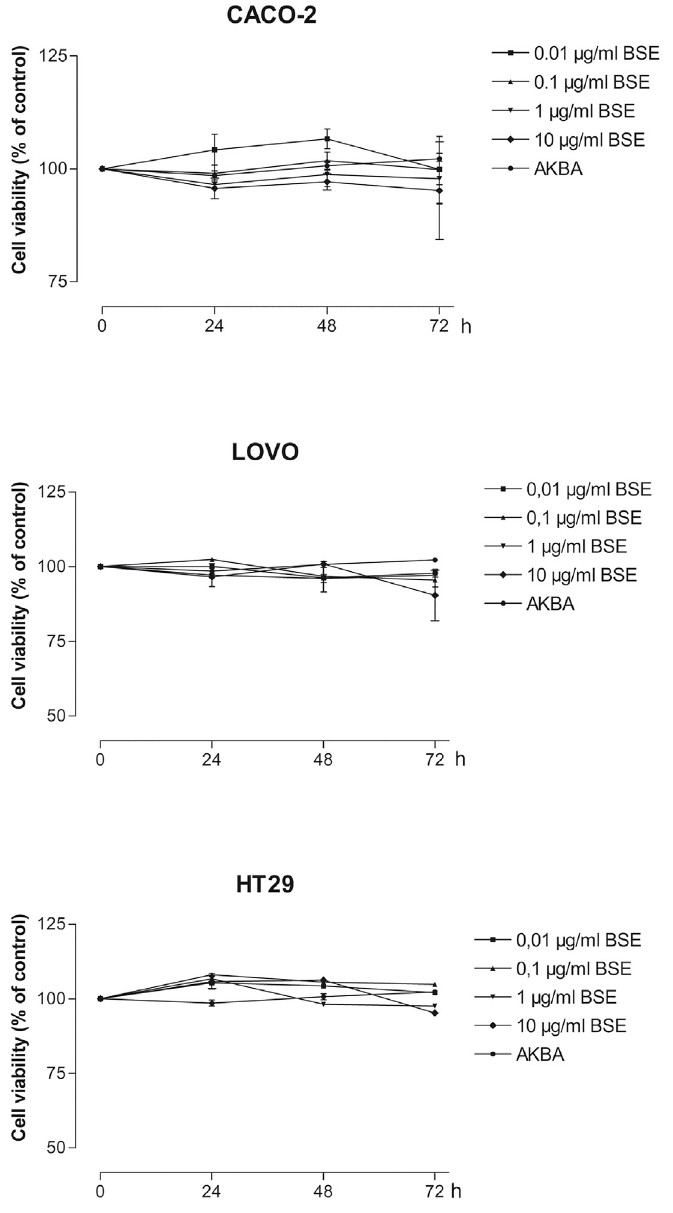
Fig 1. Effect of BSE and AKBA on cell viability measured by MTT assay in Caco-2, LoVo and HT-29 intestinal epithelial cell lines. Results are mean ± SEM of n = 4 experiments and are expressed as Absorbance Units and normalized to values in untreated cells